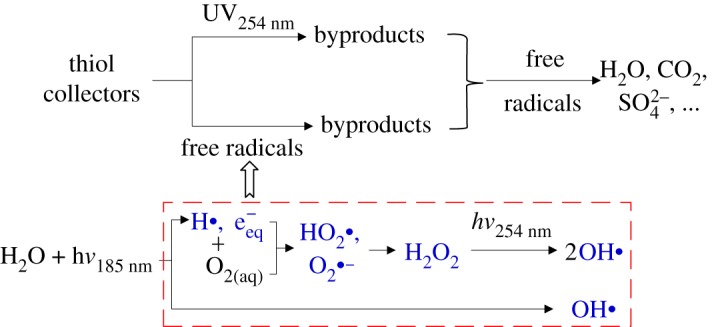
Proposed degradation mechanisms of thiol collectors under UV185+254 nm irradiation.